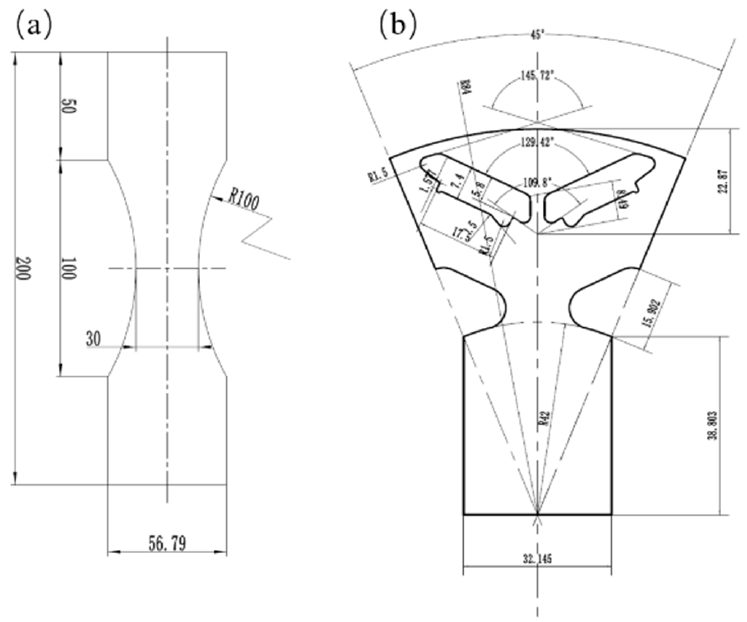
Figure 20. B30AVH1500 standard fatigue specimen ( a ) and rotor fatigue specimens ( b ) (unit: mm).